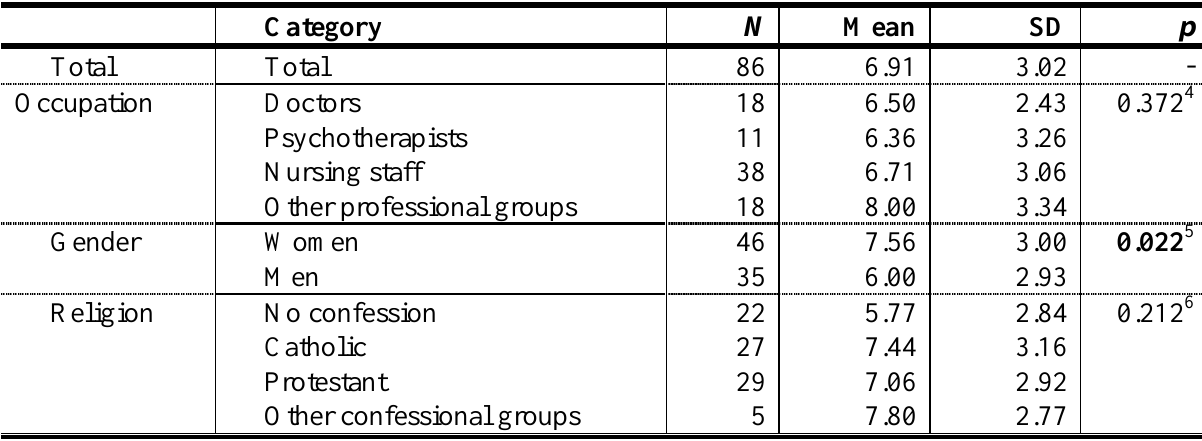
Table 2. The extent of intrinsic religiosity